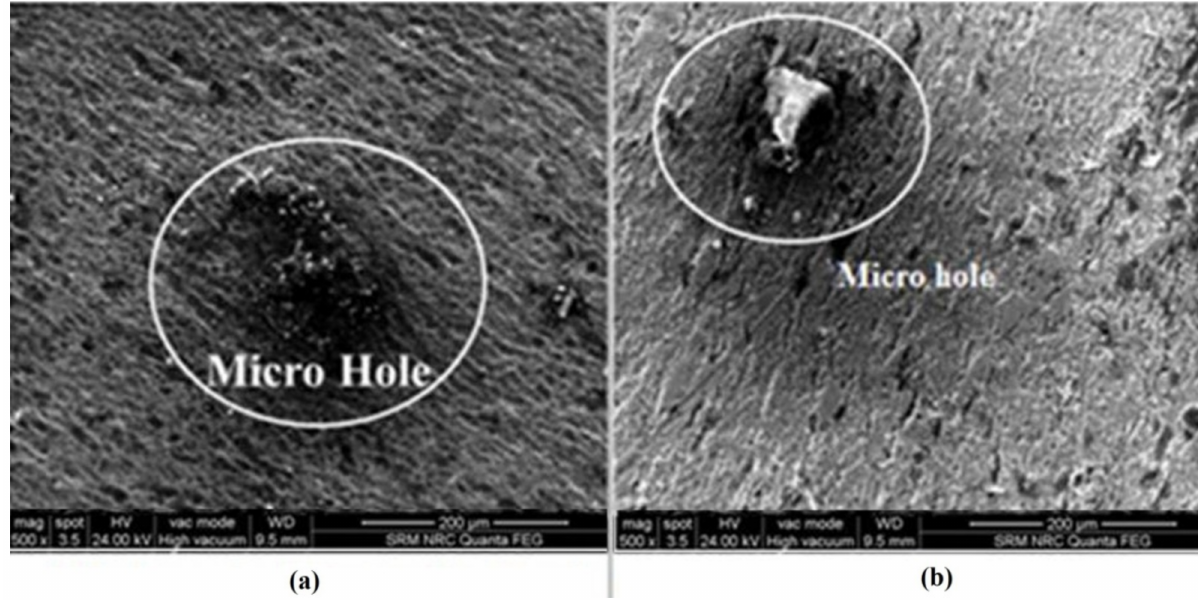
Figure 4. SEM image of machined workpiece surface by bare tool ( a ) 15 V, 1 mol/L Sodium Nitrate, 50% duty cycle ( b ) 15 V, 1 mol/L Sodium Nitrate, 66% duty